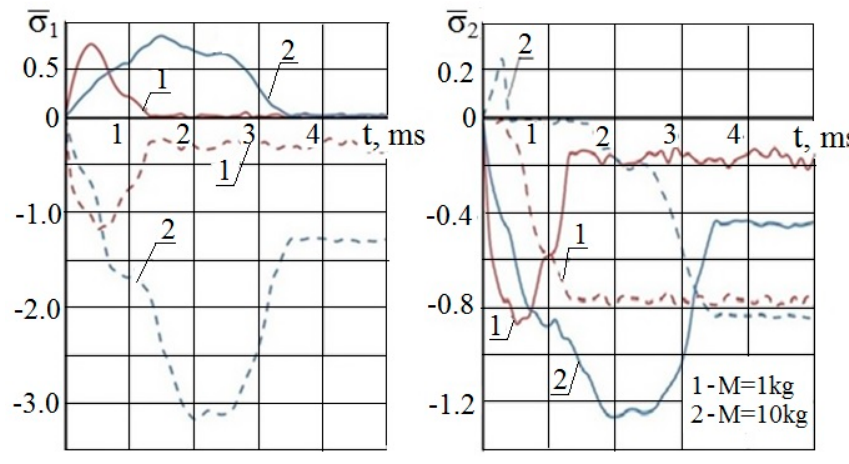
σ σ ) and matrix ( 2 ).